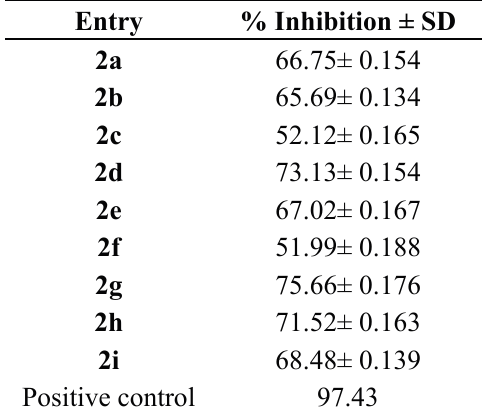
Table 4. Biofilm inhibition activity data of 5-aryl-2-bromo-3-hexylthiophene based compounds ( 2a – i